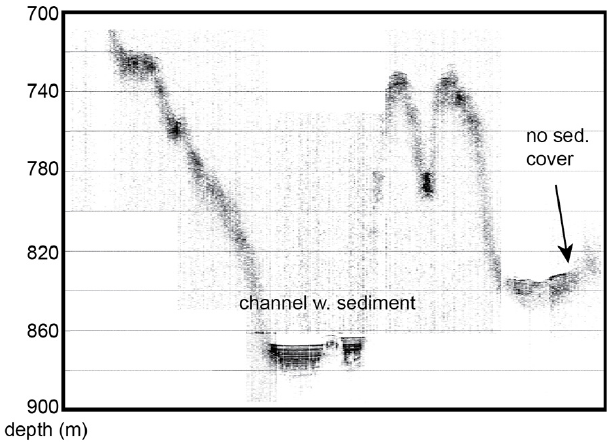
Fig. 5. PARASOUND example showing ∼ 20m of sediment fill in the channels and no sediments on slopes and ridges. See Fig. 4 for